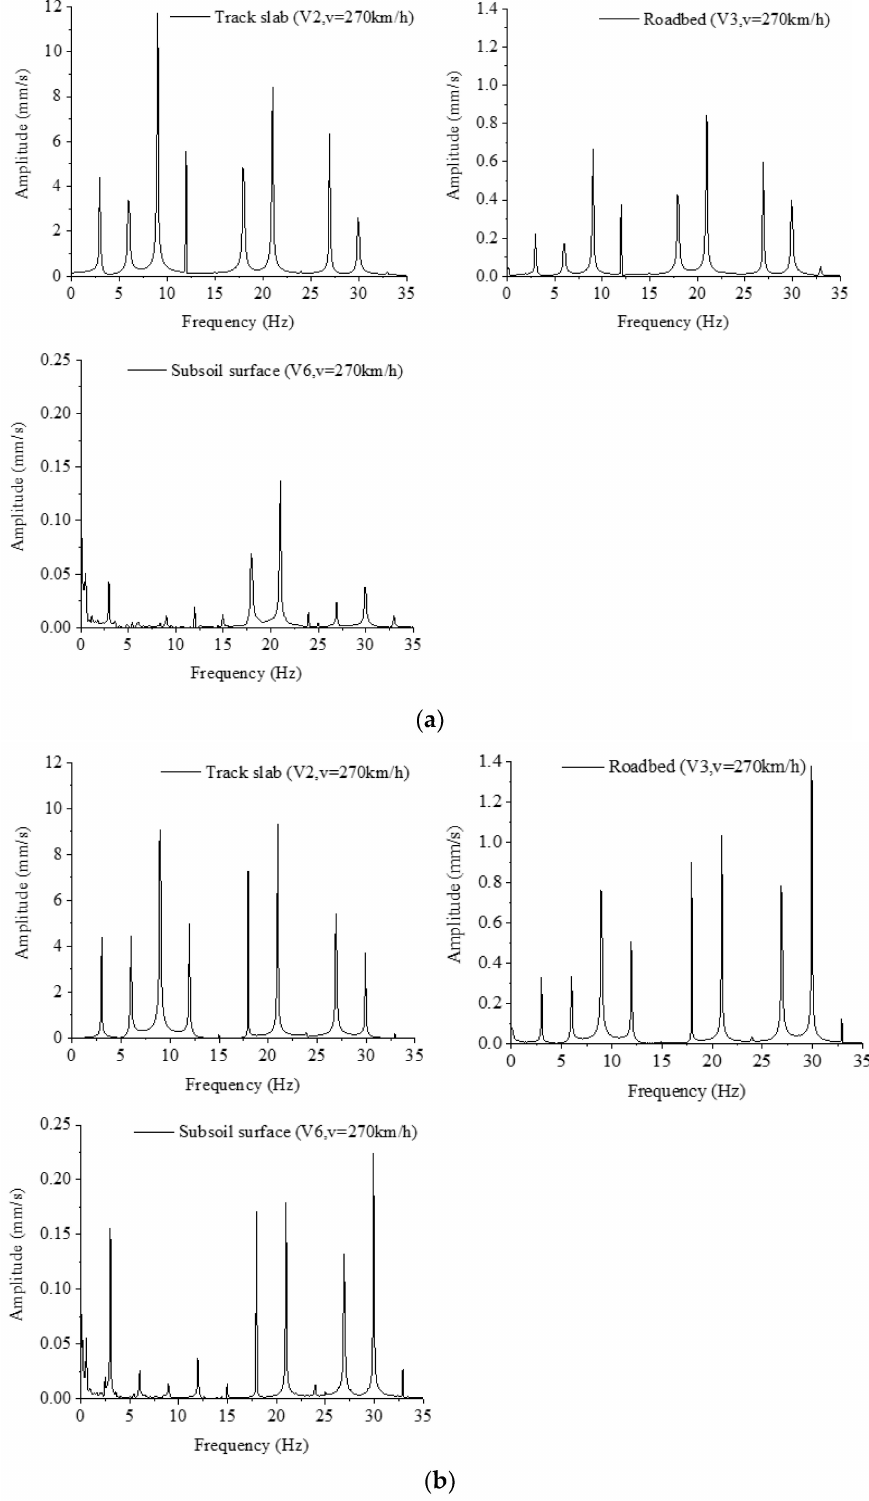
Figure 8. Frequency contents of velocity at track V2, V3, V6. ( a ) Low water level, v = 270 km/h, ( b ) High water level, v = 270